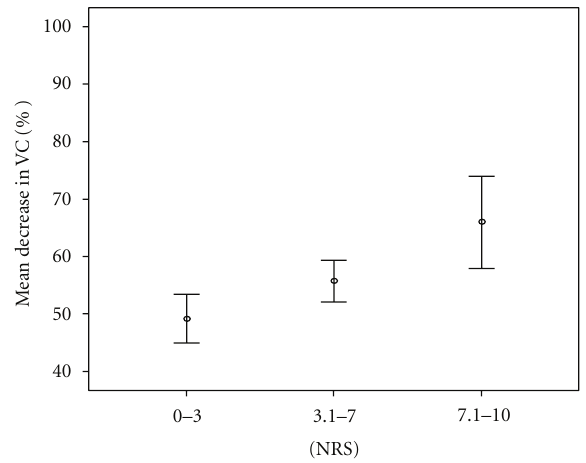
Figure 3: Mean VC, 95% CI, decrease in percent in relation to self- rated pain when moving from lying to sitting ( n = 107, NRS 0–3.0 n = 52, NRS 3.1–7.0 n = 49, NRS 7.1–10.0 n = 6). NRS: numeric rating scale, 0 = no pain, 10 = the worst imaginable pain, VC: vital capacity, P = 0 . 003 between all